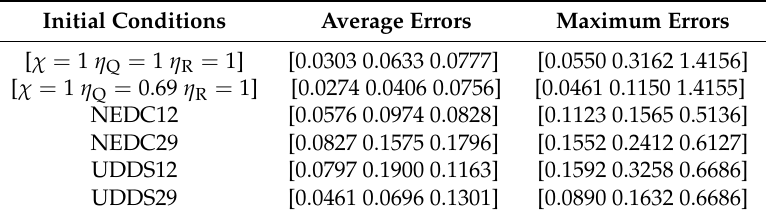
Table 2. The errors of the state estimation for the aged